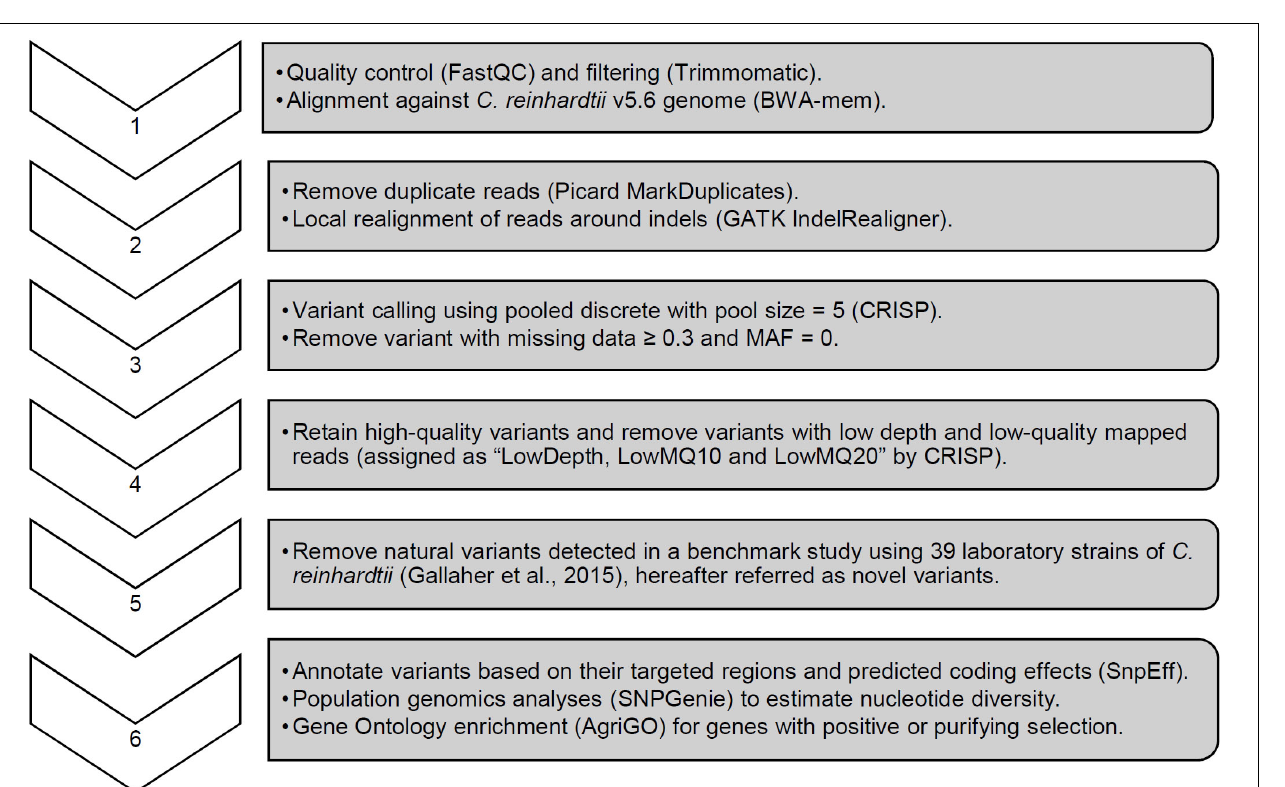
( Figure 5 , Gallaher et al., 2015). The WT strain is a sequence- verified clone of CC-1690, and the polymorphic variants identified overlapping peaks on chromosomes 2, 6, and